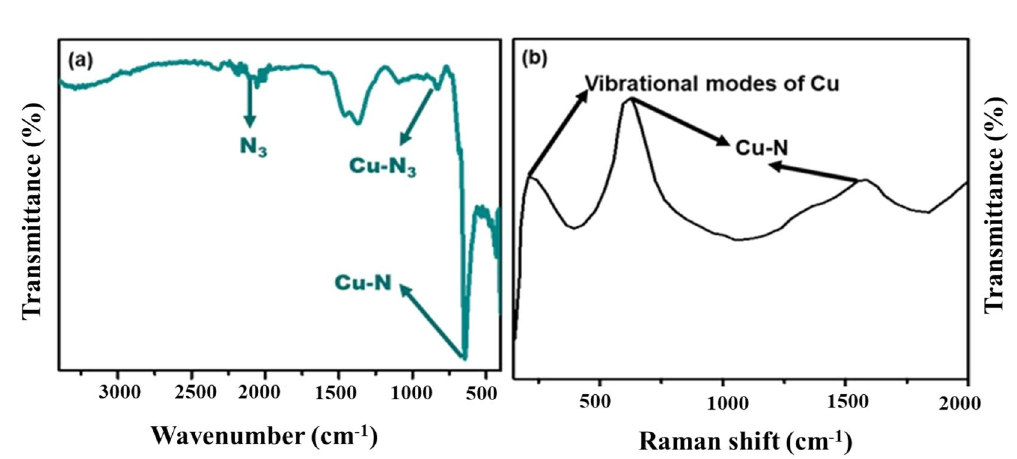
Figure 6. ( a ) FTIR and ( b ) Raman spectra of Cu 3 N (synthesized at 160 ml/min ammonia flow rate and 300